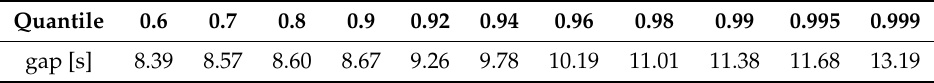
Figure 12. TDMA—example of optimization curves (mean quantiles 0.6–0.999 of BER penalty 0.8 configurations). Table 3. TDMA quantiles (mean of BER penalty 0.8